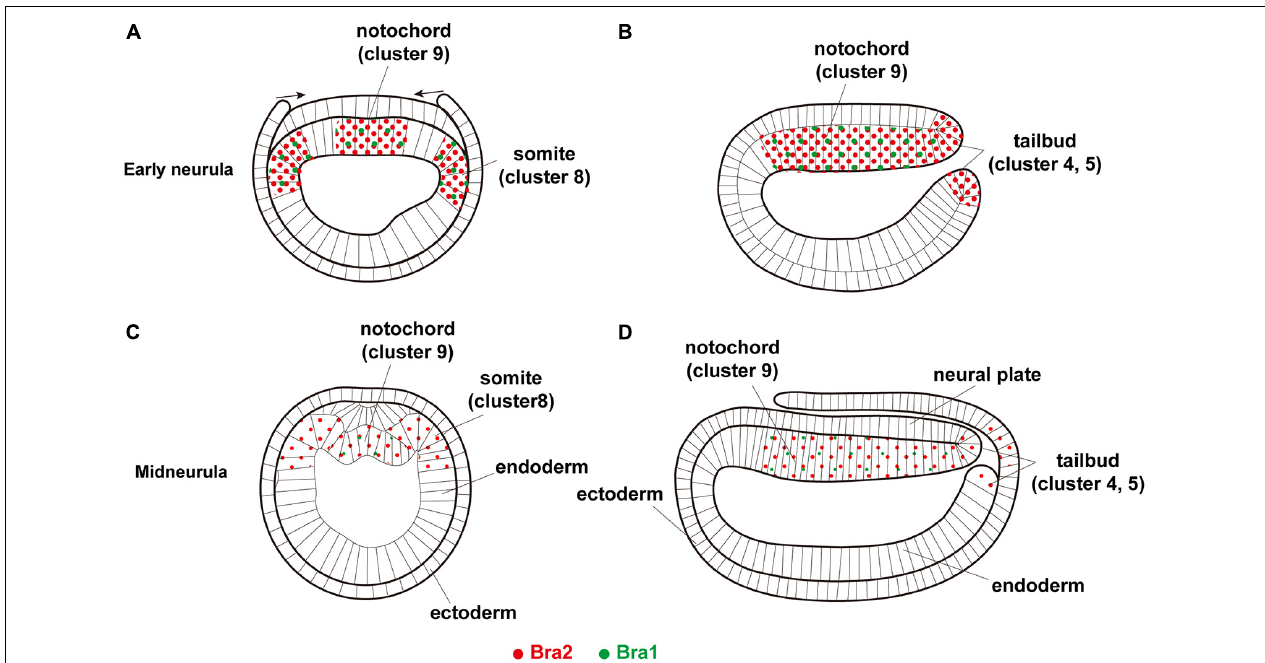
FIGURE 6 | A summary diagram showing expression of two Brachyury genes, Bra1 (green dots) and Bra2 (red dots), in (A,B) early neurula, (A) cross section and (B) sagittal section, and (C,D) midneurula, (C) cross section and (D) sagittal section. Bra1 is weakly expressed in the somite (cluster 8) and notochord (cluster 9) at early neurula and becomes undetectable in cluster 8 at midneurula, while a high level of Bra2 expression is found in the somite (cluster 8), notochord (cluster 9), and tail bud (clusters 4 and 5). Original drawing of embryos by Schubert et al.